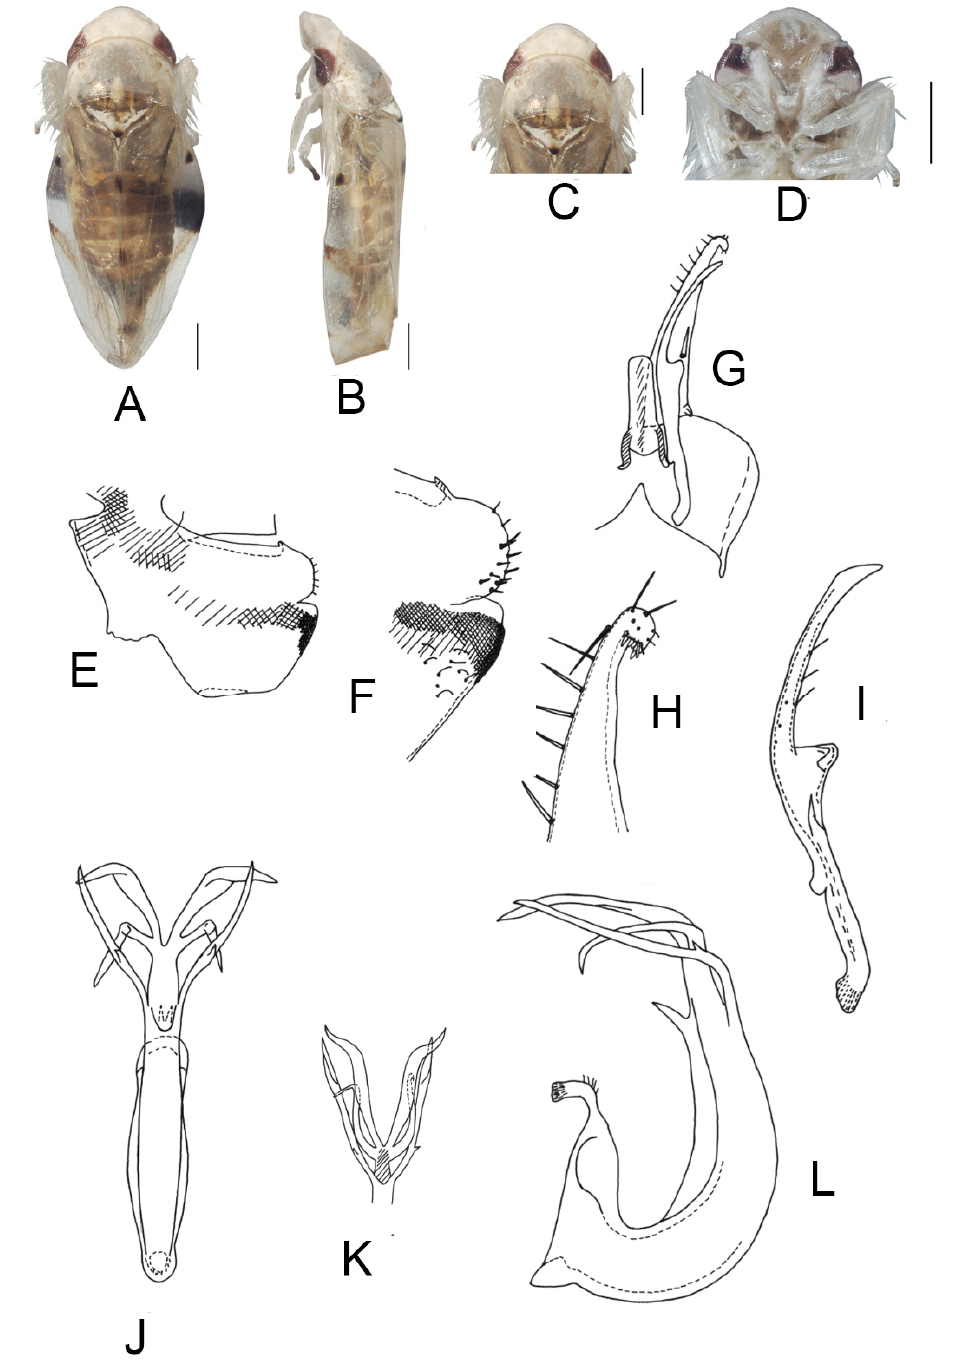
Figure 23. Eurhadina ( Singhardina ) zadyma rec. nov. ( E – L : Dworakowska, 2002 [3]): ( A ) habitus, dorsal view; ( B ) habitus, lateral view; ( C ) head and thorax, dorsal view; ( D ) face; ( E ) male pygofer side, lateral view; ( F ) hind part of pygofer, lateral view; ( G ) subgenital plate, connective, paramere and sternite IX, dorsal view; ( H ) apex of subgenital plate, dorsal view; ( I ) paramere, dorsal view; ( J ) aedeagus, posterior view; ( K ) apex of aedeagal shaft, dorsal view; and ( L ) aedeagus, lateral view. Scale bars: 0.5 mm.